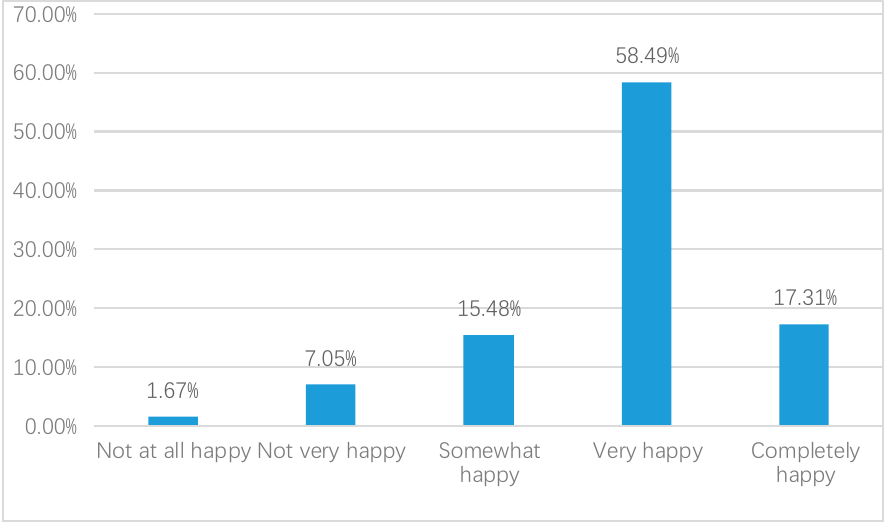
Figure 4. Happiness (weighted).